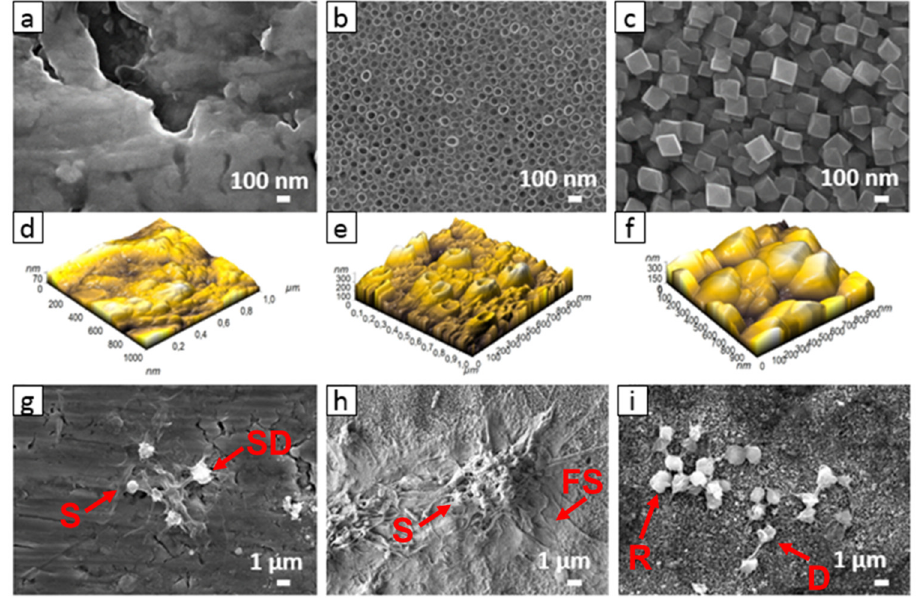
Figure 6. SEM and AFM images of Ti foil ( a , d ), TiO 2 nanotubular surface ( b , e ), and TiO 2 octahedral surface ( c , f ), and the adhered blood platelets on these three kinds of surfaces ( g – i ).